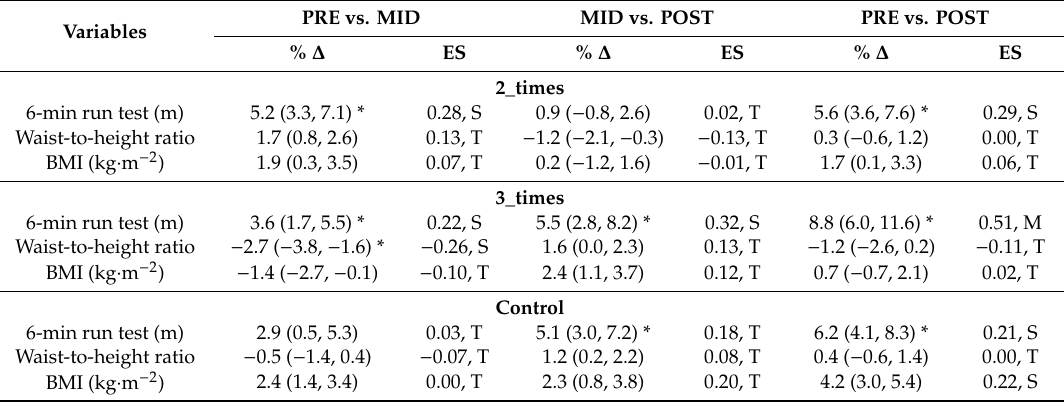
Table 2. Percentage difference from pre-, mid-, and post-test and repeated measure outcomes.